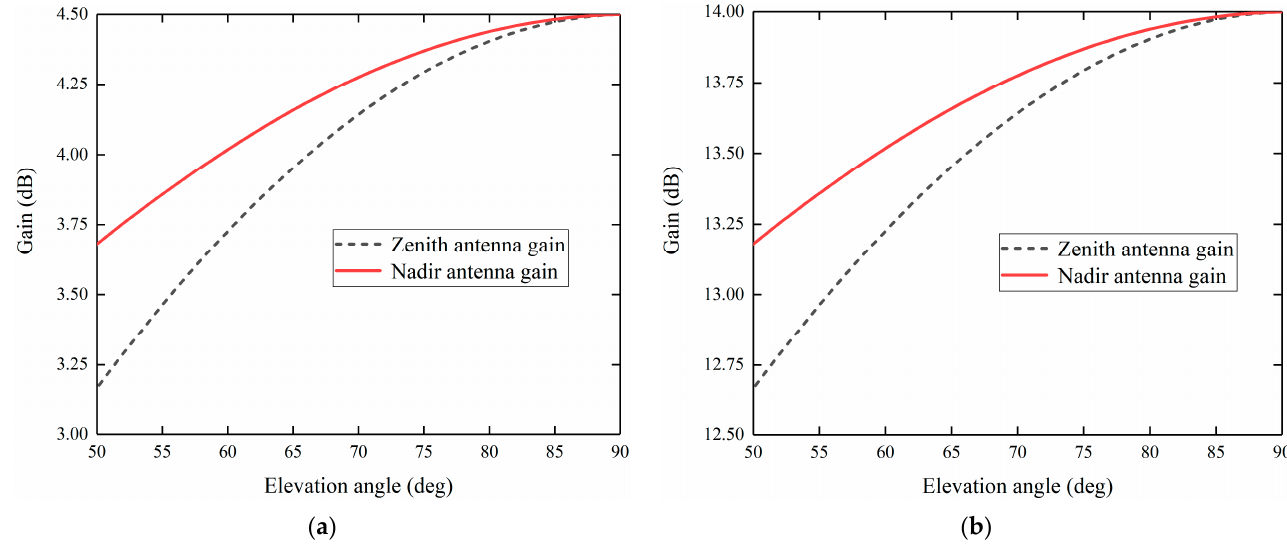
Figure 8. ( a ) TEA and Comparison of measured gain between ( b ) NDCPPA model verification prototype.